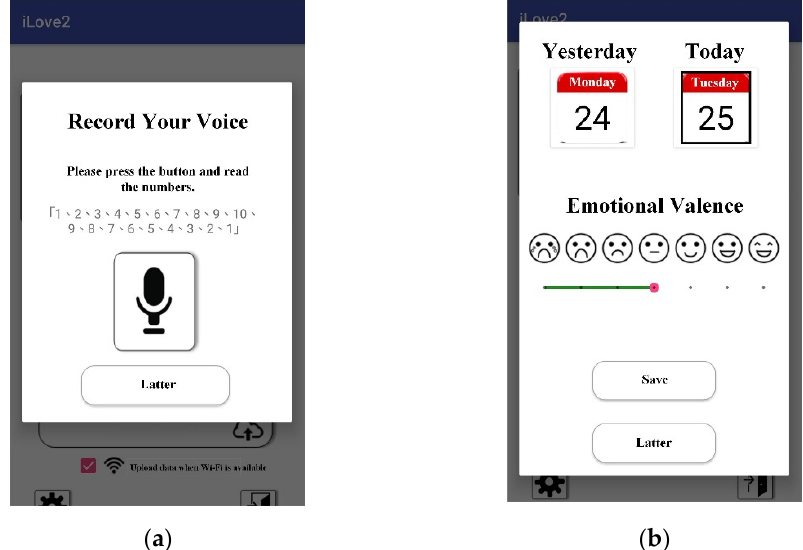
Figure 1. The self-developed iLove app. ( a ) Daily voice recording screenshot of iLove on which the participant record a daily voice clip while reading “1, 2, 3, 4, 5, 6, 7, 8, 9, 10, 9, 8, 7, 6, 5, 4, 3, 2, 1” in Chinese; ( b ) daily emotional valence reporting screenshot of iLove on which the participant reported their daily emotional valence by selecting responding facial expressions.